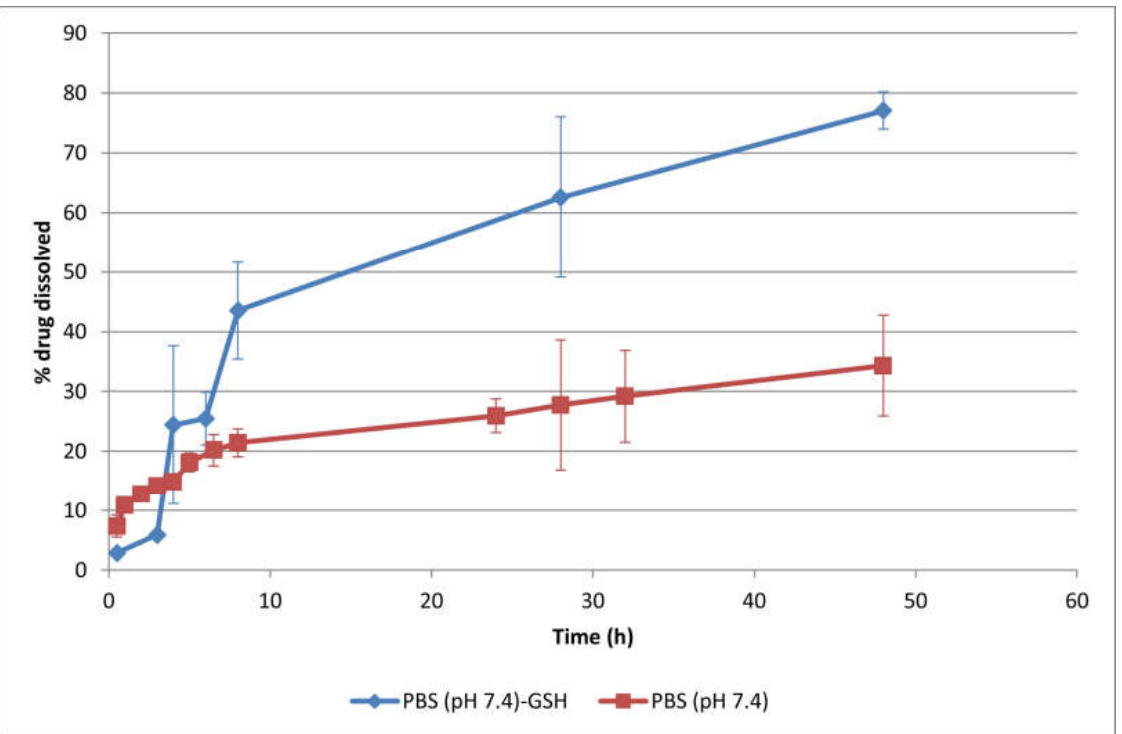
Figure 10. Cumulative in vitro release profiles of drug-loaded (10 wt.% Dox·HCl) polymersomes in PBS (10 mM, pH 7.4) with or without 50 mM GSH at 37 °C (mean ± SD, n = 3).